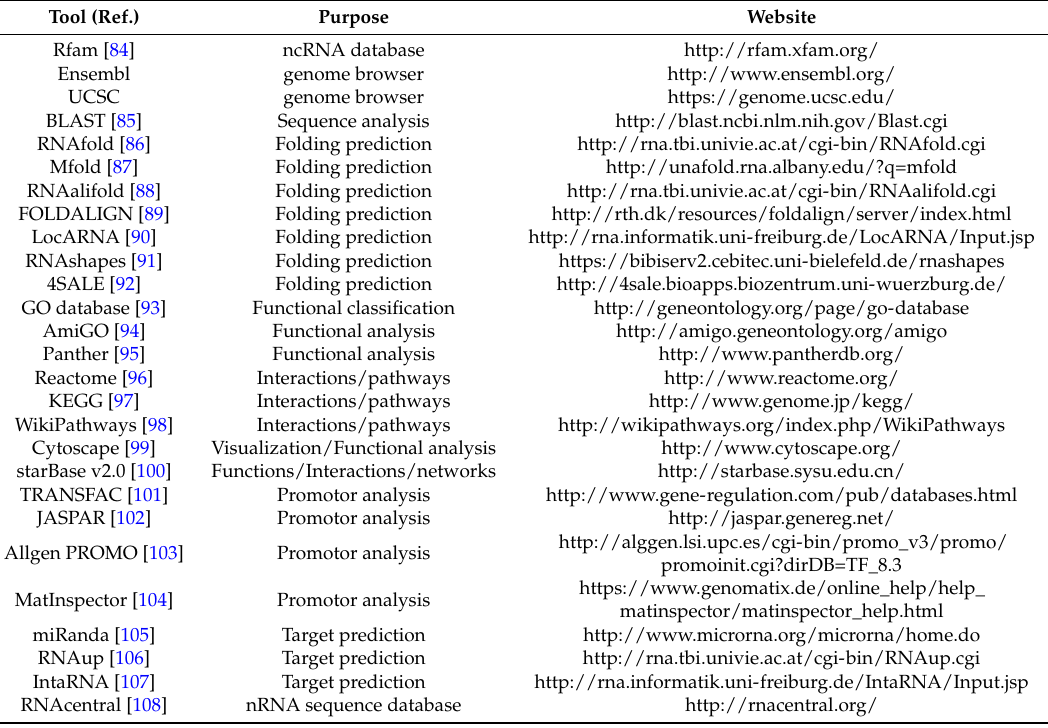
Table 3. Databases and software packages for ncRNA research.